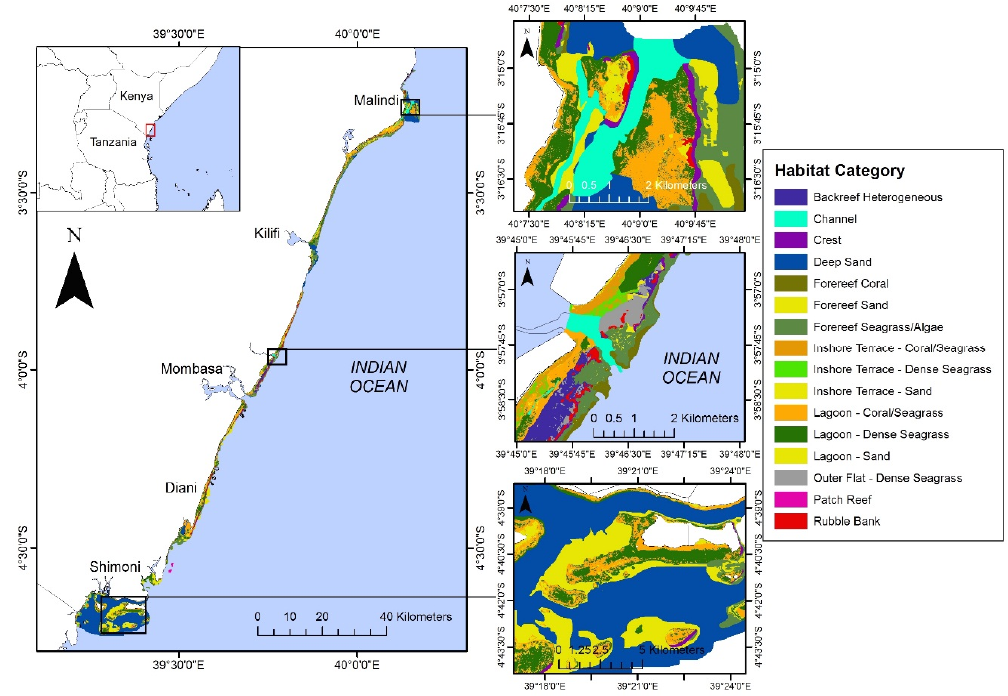
Figure 3. Map of habitat classification along Kenyan coast with selected areas highlighted to illustrate details.